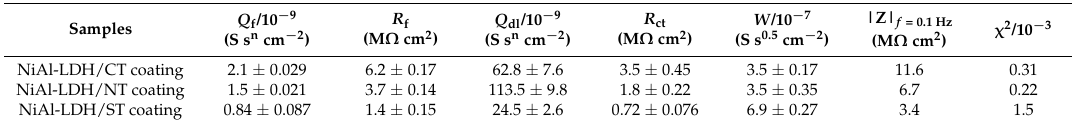
Figure 6. The equivalent circuit models used for fitting the EIS results of the ( a ) bare Mg alloy and ( b ) different NiAl-LDH coatings. The equivalent circuit (EC) model of the Mg alloy for fitting is R s ( Q dl R ct ( R L L)) where R s is solution resistance, Q dl is double layer capacitance, R ct is charge transfer resistance, R L is inductance resistance, and L is inductance. The EC model for coatings is R s ( Q f ( R f ( Q dl ( R ct Z w )))) where Q f and R f are capacitance and resistance of the coatings, respectively. Z w is Warburg diffusion resistance. Table 2. Parameters of EIS for three different NiAl-LDH coatings.